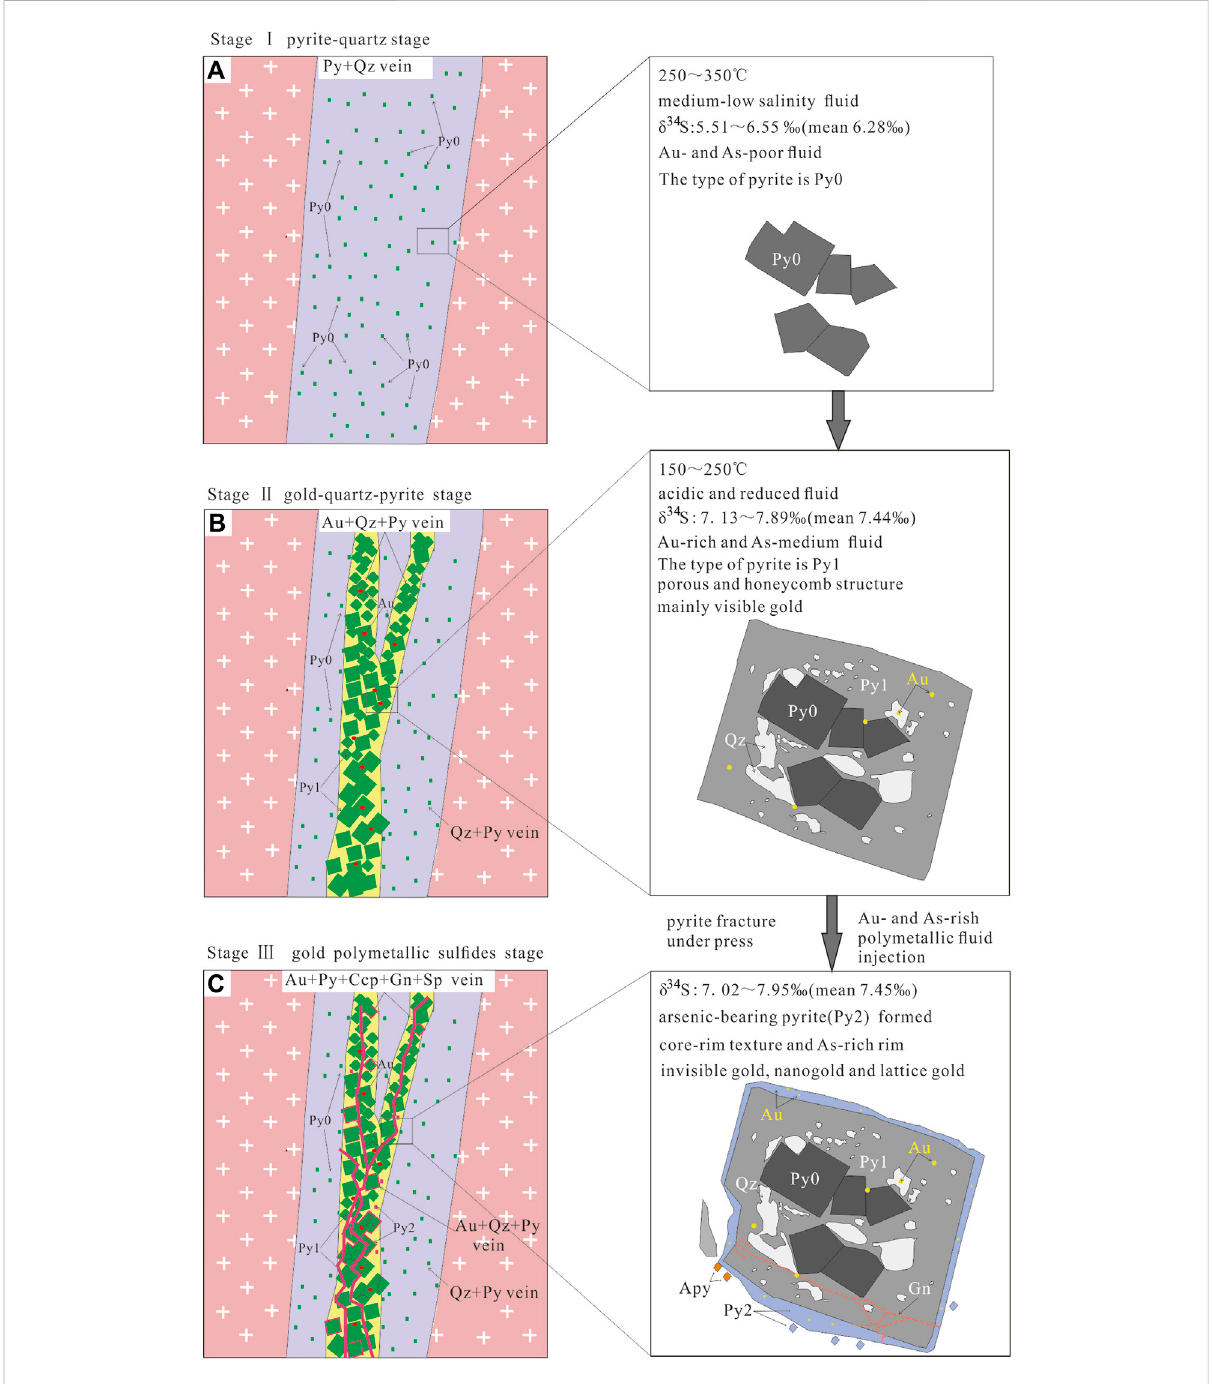
FIGURE 13 Gold metallogenic process of Houge ’ zhuang gold deposit for different mineralization